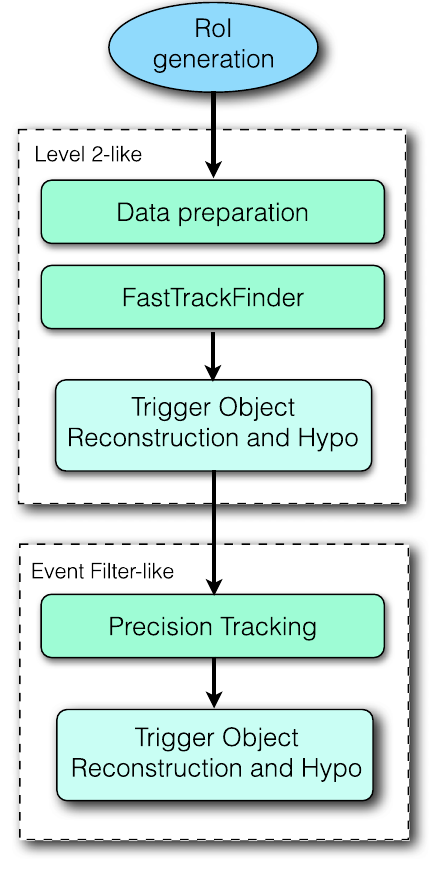
Fig. 5 Schematicillustratingthesingle-stagetrackingforasingleRoI. Here single-stage refers to the single processing of a specific RoI, rather than the separate steps in the track processing itself. Selection can be applied in hypothesis algorithms (hypos) which reduce the rate for pro- cessing the later